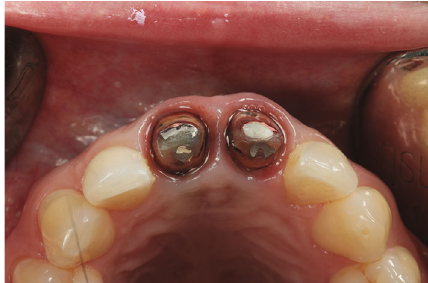
Figure 26: Occlusal view of the stump of 1.1 and 2.1 based on the BOPT approach.